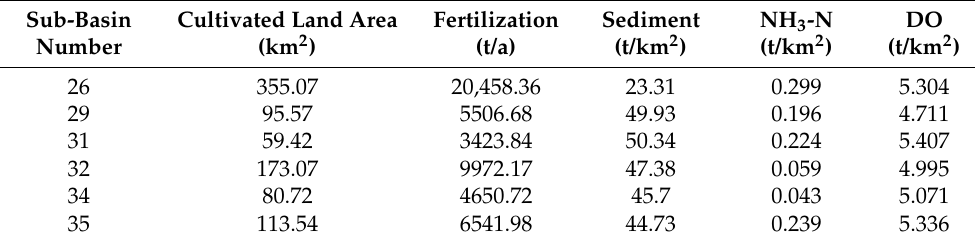
Table 7. Statistical table of cultivated land area, fertilization amount, and pollutant load amount in key source areas.